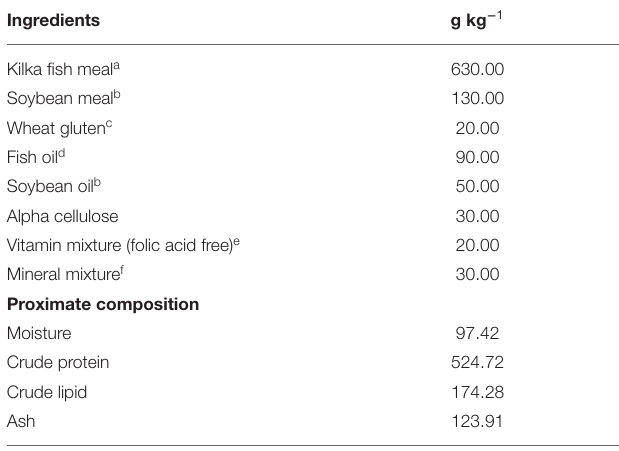
TABLE 1 | Ingredients and proximate compositions of the basal diet for rainbow trout, Oncorhynchus mykiss .